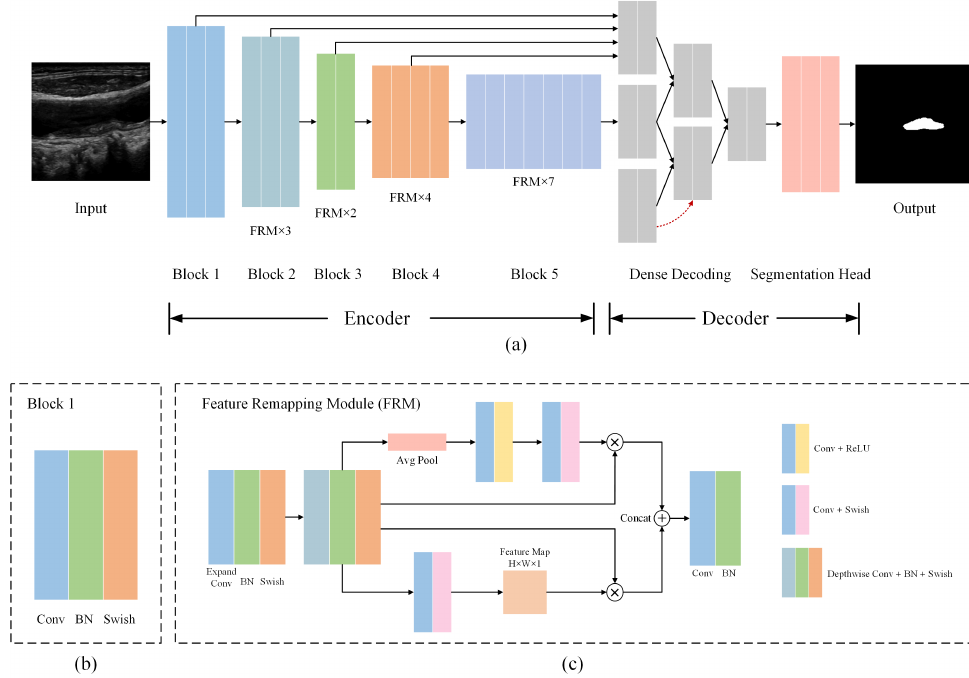
Figure 1. Overall architecture of FRDD-Net. ( a ) Full flowchart of FRDD-Net. ( b ) Detailed structure of encoding block 1. ( c ) Detailed structure of feature remapping modules